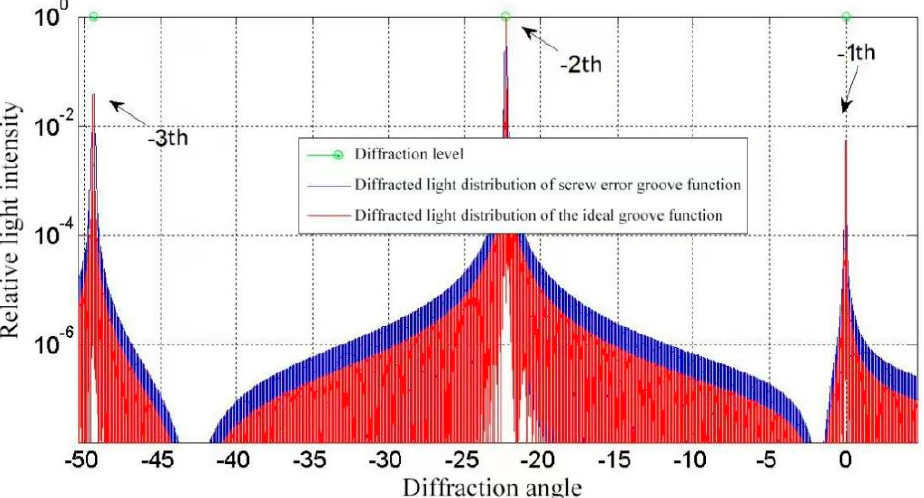
Figure 7. The relative intensity distribution of diffracted light.